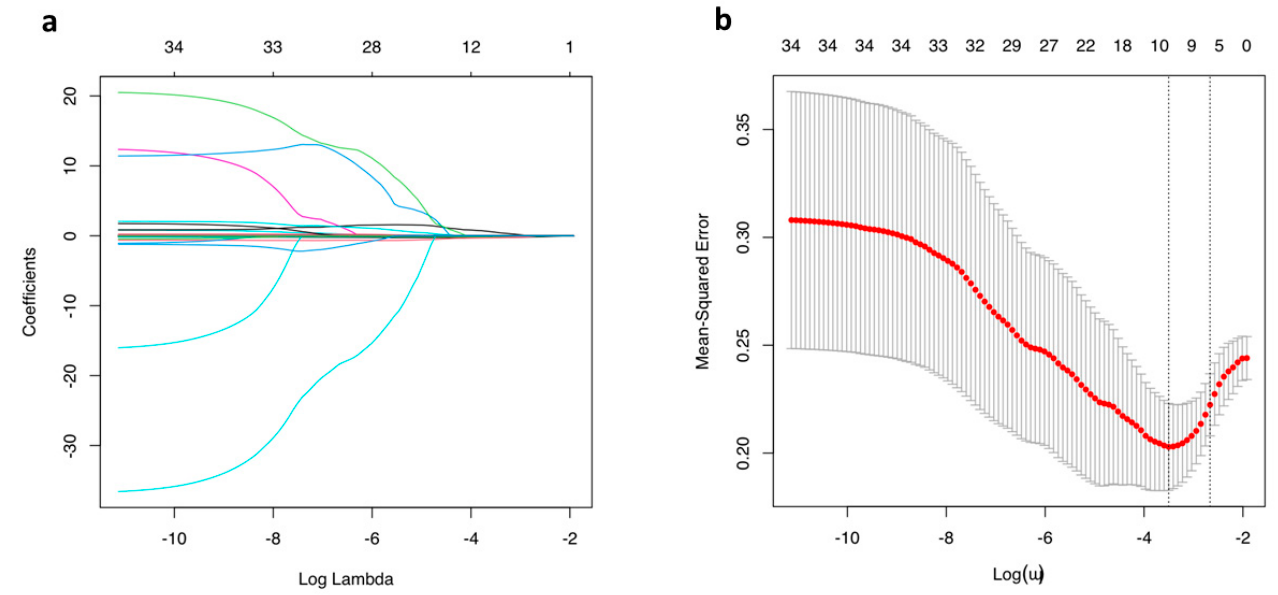
Figure 2. Coefficients ( a ) and cross-validation ( b ) plots of the LASSO